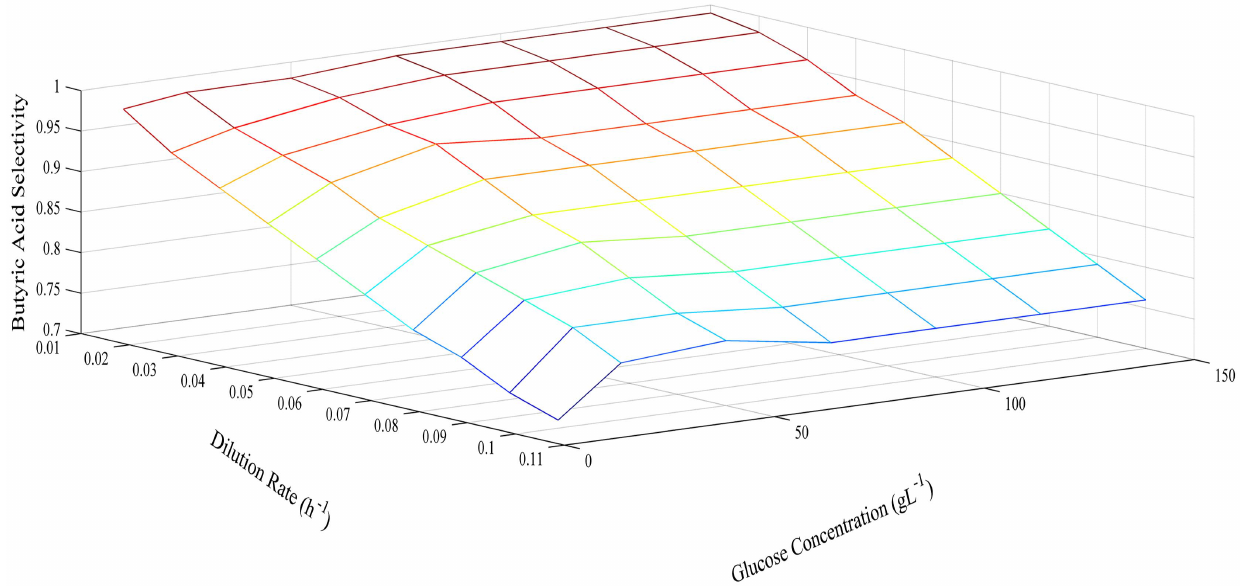
Figure 6. Simulated effects of dilution rate and glucose feed concentration on butyrate selectivity. Color differences indicate gradient.